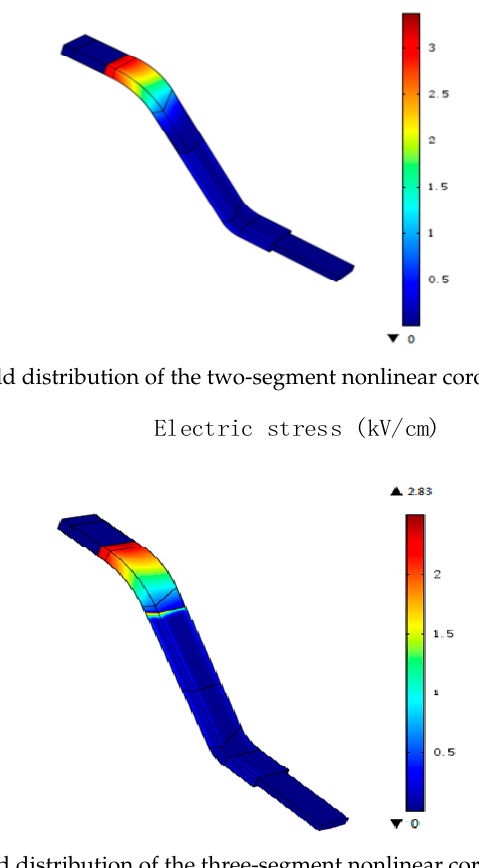
Figure 6. Electric field distribution of the three-segment nonlinear corona protection structure.